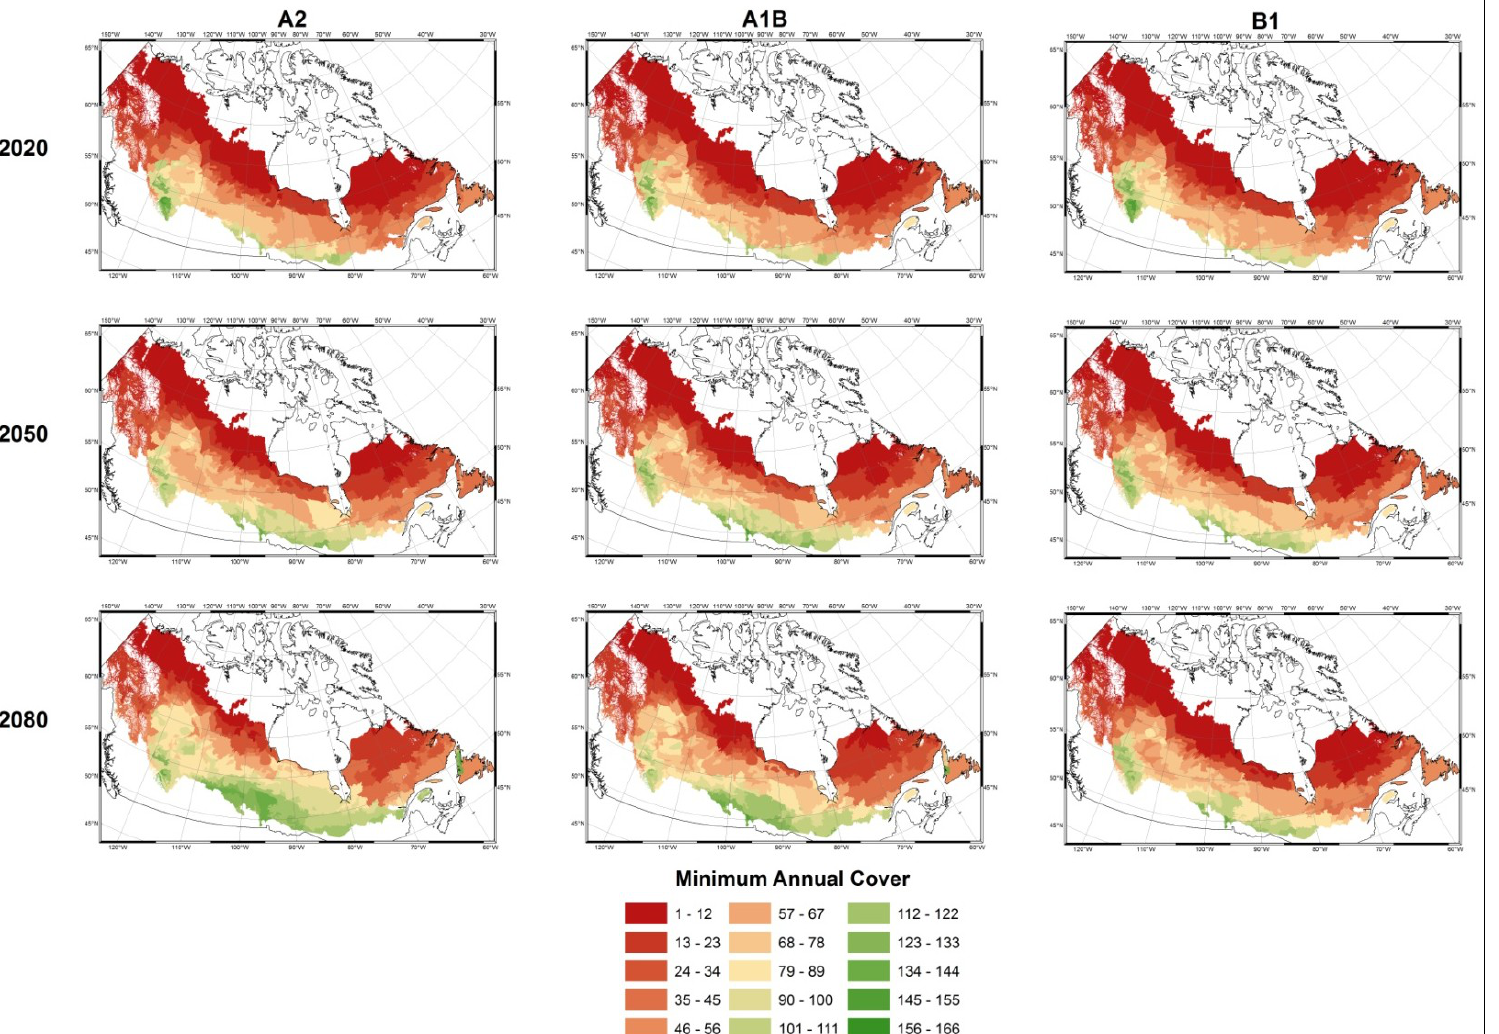
Figure 5. Predicted spatial distribution of minimum annual cover for 2020, 2050, and 2080 based on three IPCC climate change scenarios: A2 (most change), A1B (business as usual), and B1 (least